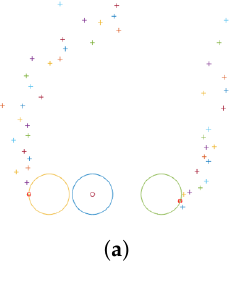
Figure 4. Steps of the edge detection algorithm applied on both sides of the robot. The center of the blue circle at the bottom of each figure corresponds to the position of the robot. ( a ) shows the translated circles and the initial points of the chains. ( b ) shows the rotation of the circles along each previous point of the chain. ( c ) shows the obtained chain for the left and the right side. ( d ) shows the polynomial regressions of the